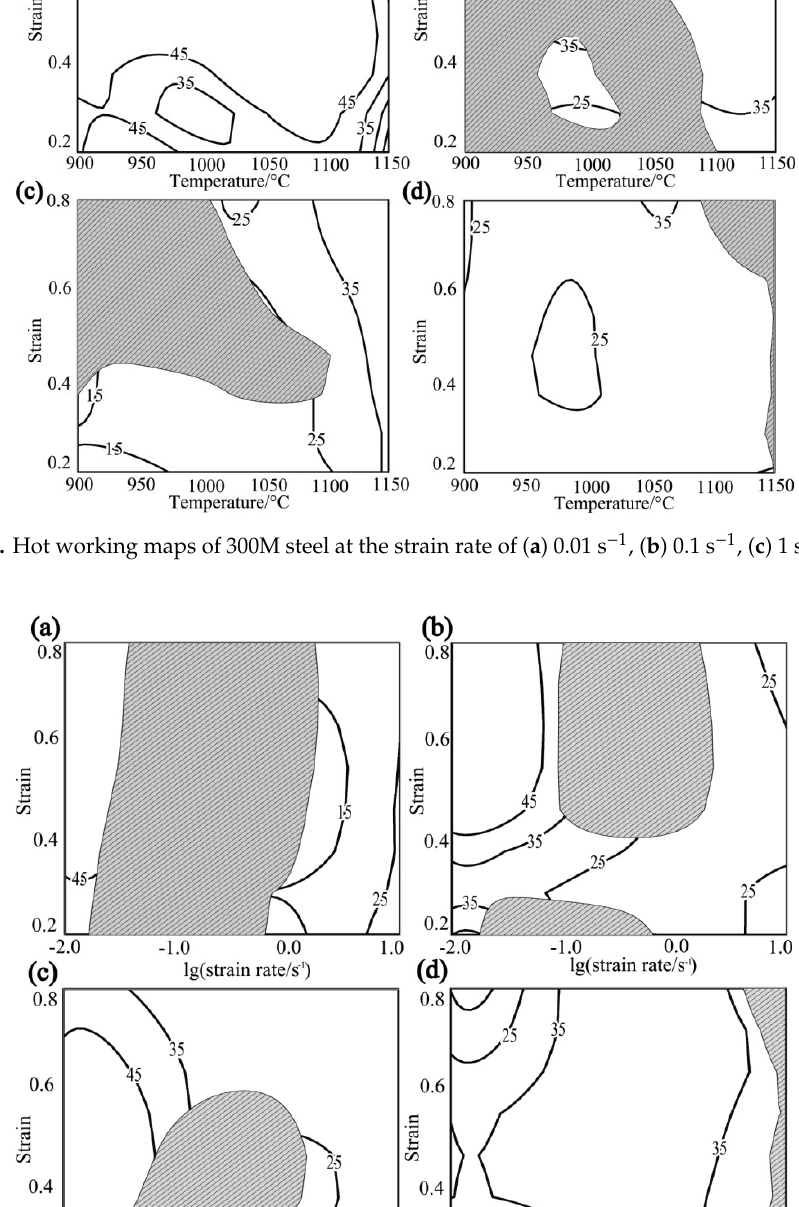
Figure 11. Hot working maps of 300M steel at the temperature of ( a ) 900 °C, ( b ) 1000 °C, ( c ) 1100 °C, and ( d ) 1150 °C.